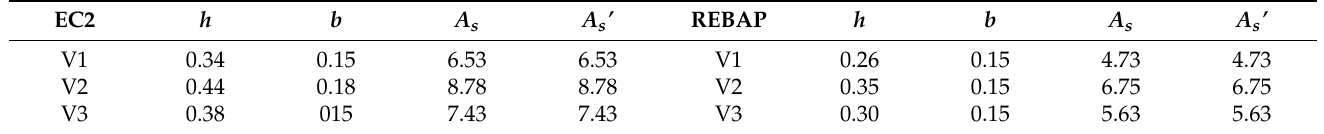
Table 5. Beams dimension for first case of study ( h , b , As , As’ values in m and cm 2 ). EC2